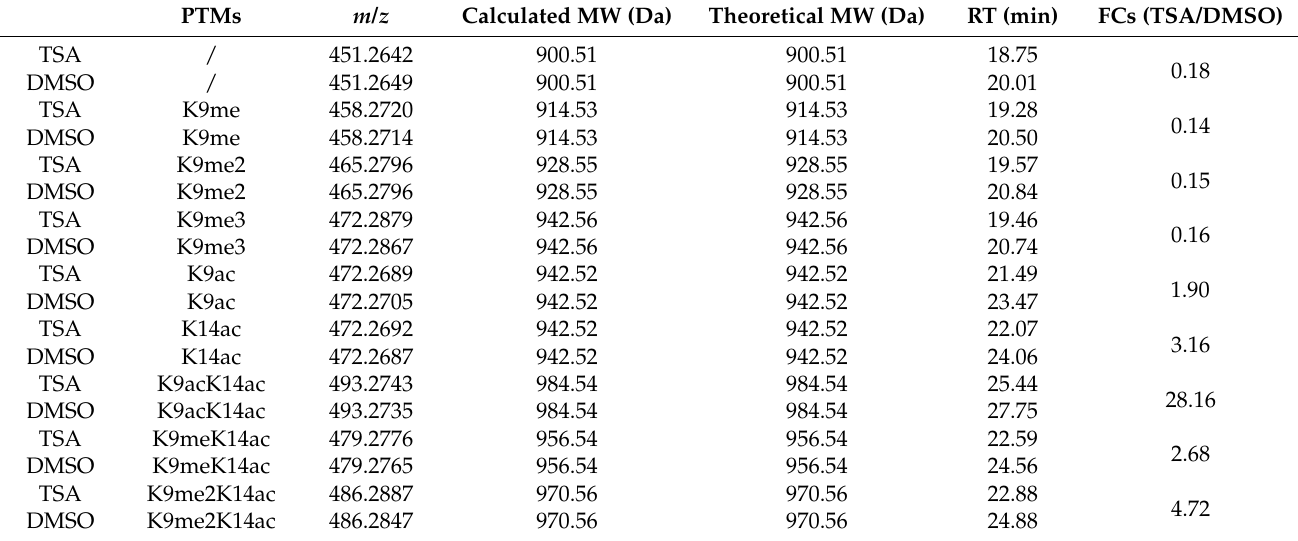
Table 2. Results of LC-MS/MS analysis of H3 9–17 peptide: post-translational modifications (PTMs), m / z signal, calculated and theoretical molecular weight (MW), retention time (RT), and peptide fold change (FC) are reported for each